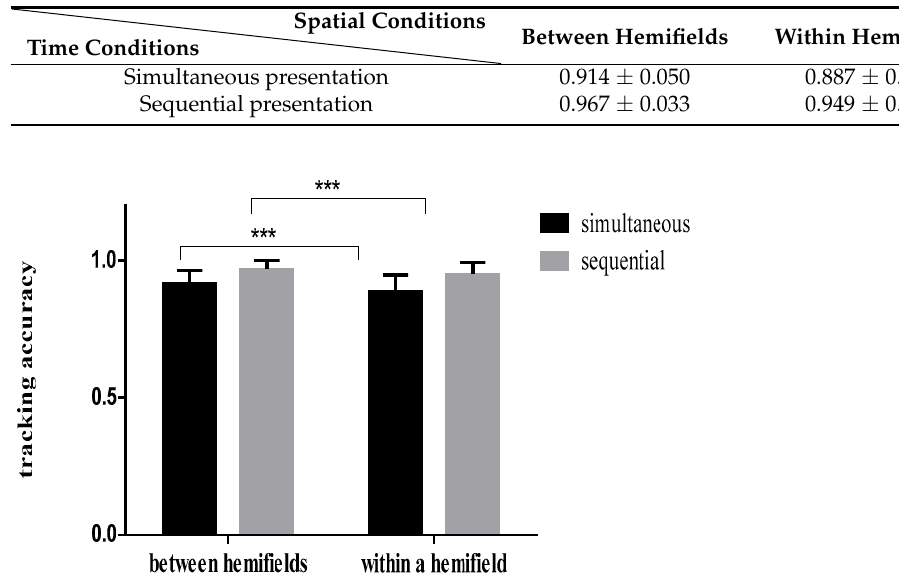
Figure 5. Comparison of tracing accuracy of different presentation conditions under simultaneous and sequential conditions. Note: *** indicates the significance level is p < 0.001.